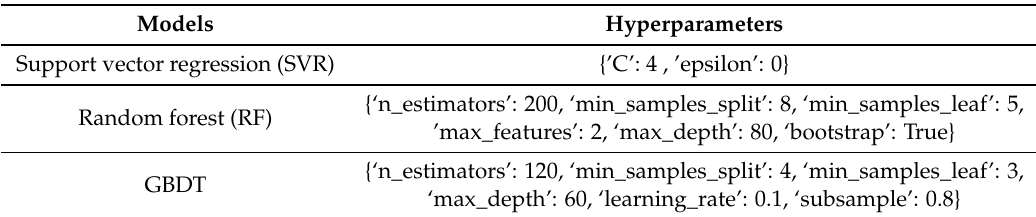
Table 2. Hyperparameters for each model.